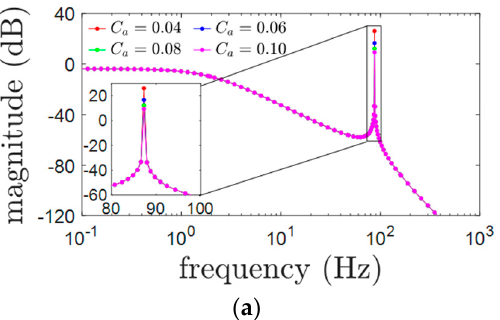
Figure 6. The translational vibration of the flywheel rotor along the axial direction. ( a ) The translational vibration amplitudes of the flywheel rotor with different damping coefficients; ( b ) the translational vibration amplitudes of the flywheel rotor with different stiffness coefficients.